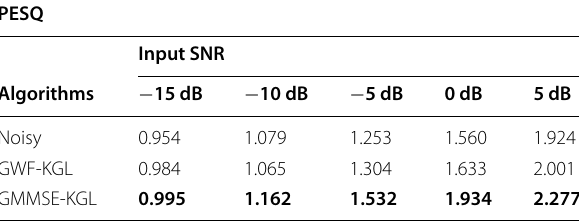
Table 2 The PESQ of different graph speech enhancement methods followed by the K -graphs learning method PESQ